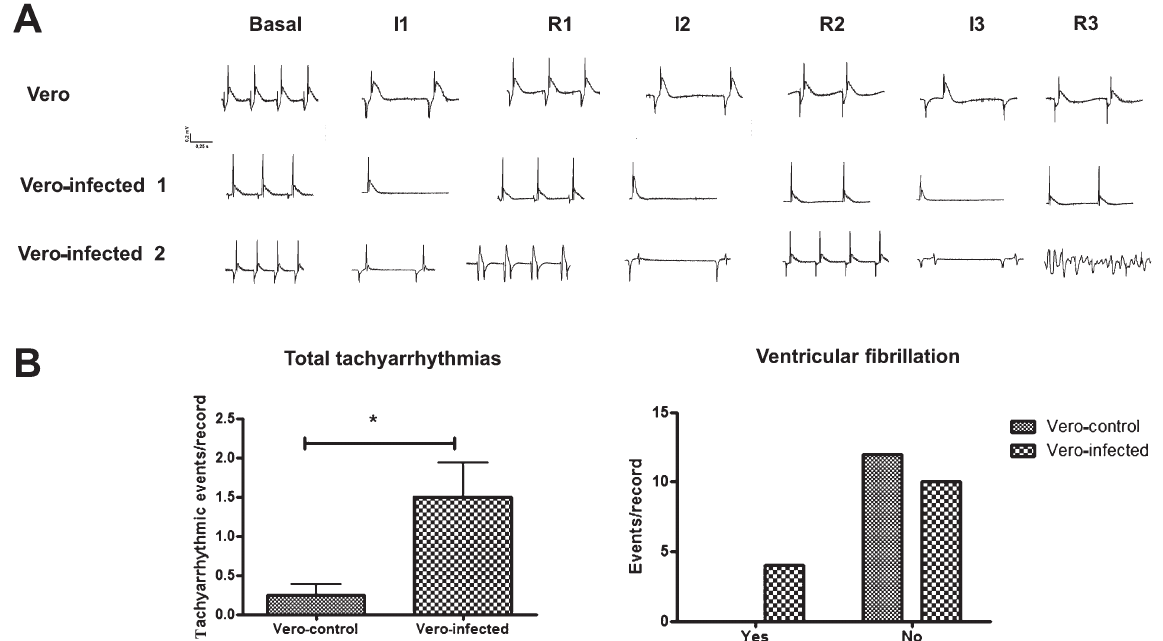
Figure 3. Panel A shows representative ECG recordings of the ischemia-reperfusion process for different perfused media. The figure shows the ECG recordings during the different stages of ischemia-reperfusion processes, which were identified as I1, I2, I3 for the three ischemia stages and as R1, R2, and R3 for the reperfusion ones. The upper recording shows the ECG of an isolated beating heart perfused with Vero cell-conditioned medium (Vero-control), and the middle and bottom recordings show ECGs of two different isolated beating hearts perfused with Vero-infected-conditioned medium. Panel B shows a numerical comparison of tachyarrhythmia and ventricular fibrillation events between Vero-control and Vero-infected perfused hearts. The P value was 0.0138 in tachyarrhythmia comparison (Student t -test) and 0.0441 in ventricular fibrillation comparison (chi-square